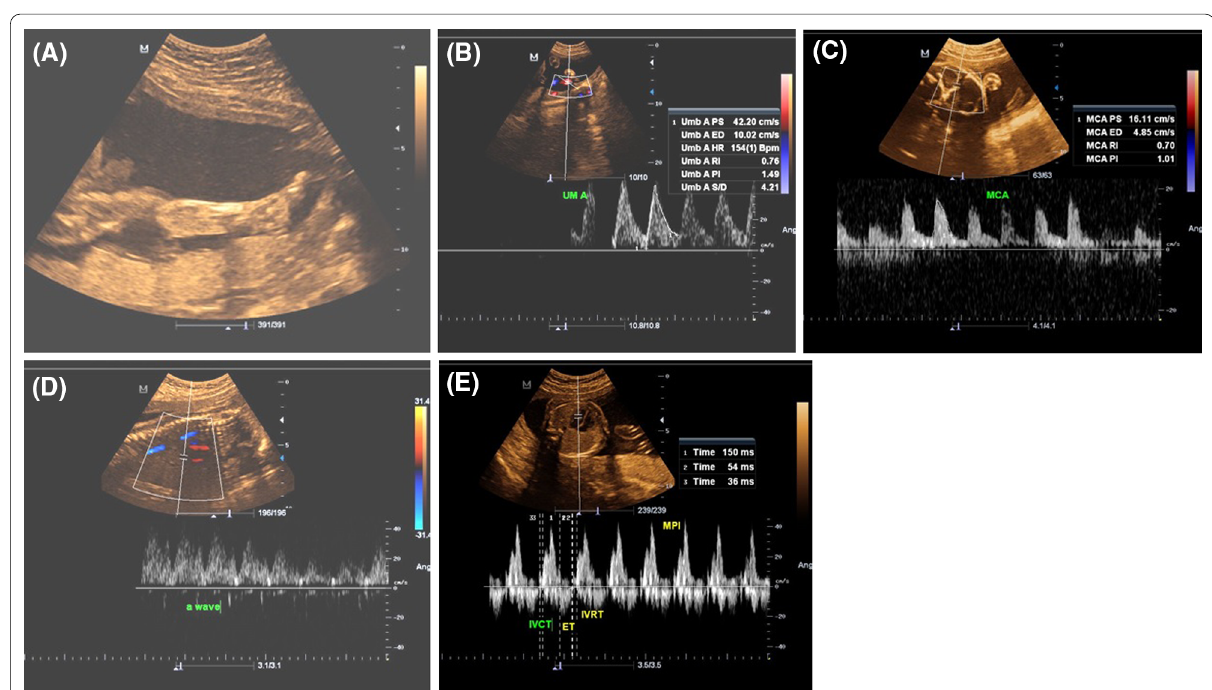
Fig. 5 A 28-year-old primigravida patient, was examined at 34 weeks gestation, had an US foetal age of 31 weeks and foetal weight of 1860 gm.